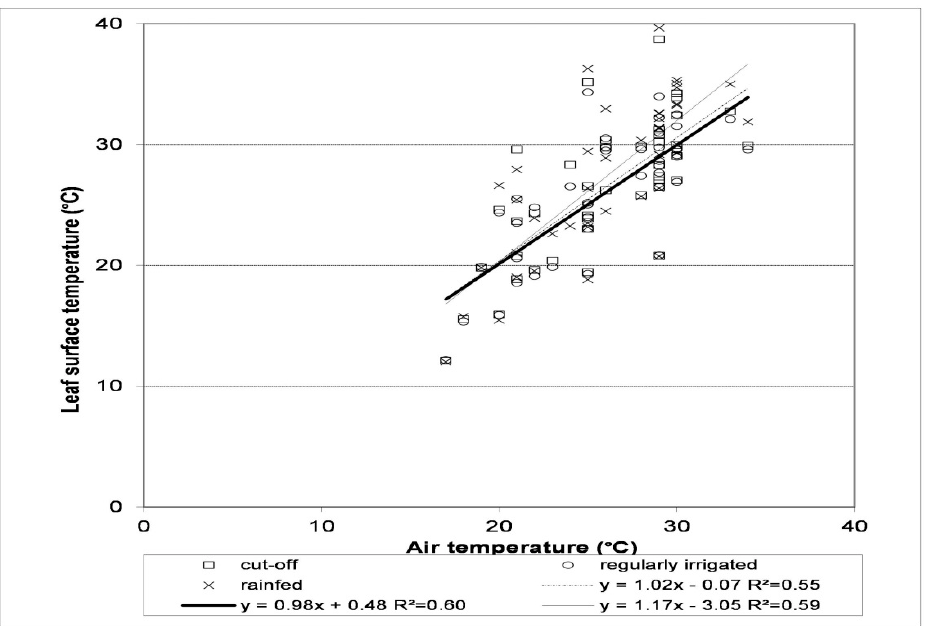
Figure 3. Relationship between the air and canopy temperature for the Kecskeméti jubileum tomato variety under rain-fed (thin line), cut-off (broken line) and regularly irrigated (thick line) conditions Source: Helyes et al. [31].